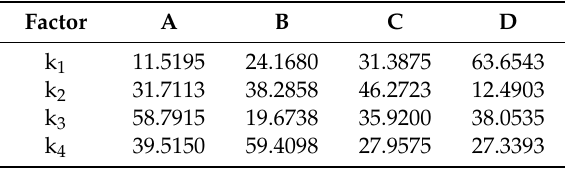
Table 4. The orthogonal experiment results calculation